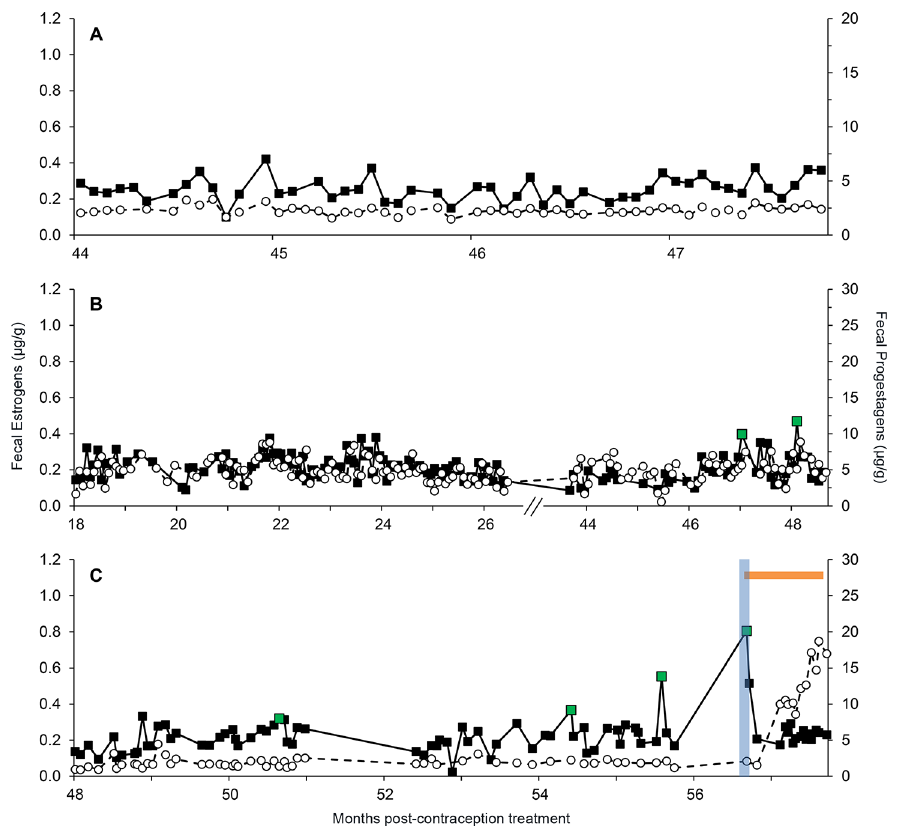
Fig 6. Fecal steroid hormone profiles ( μ g/g, FEM: filled squares, FPM: open circles) for three females contracepted with Suprelorin. Panel A (SB200), Panel B (SB283), Panel C (SB218). Baseline and threshold estrogen concentrations are denoted by dashed and dotted lines, respectively. Green data points, a blue vertical bar and an orange horizontal bar indicate estrous peaks, breeding and pregnancy,